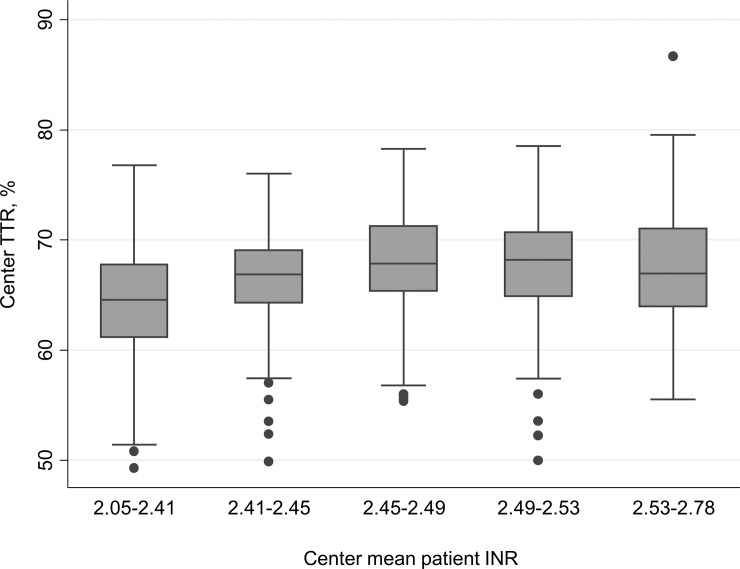
Boxplot of Center TTR by quintiles of Center mean patient INR, showing an inverse U-shaped relationship between mean patient INR and TTR.